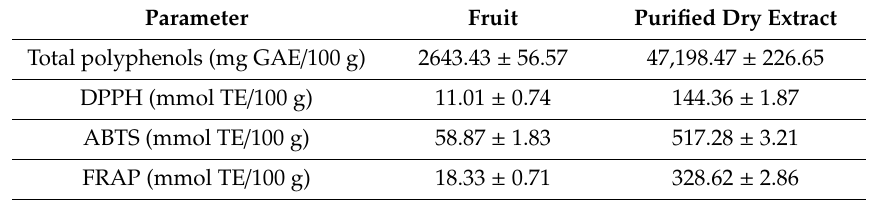
Table 1. Total polyphenols and antioxidant potential of R. spinosissima and purified dry